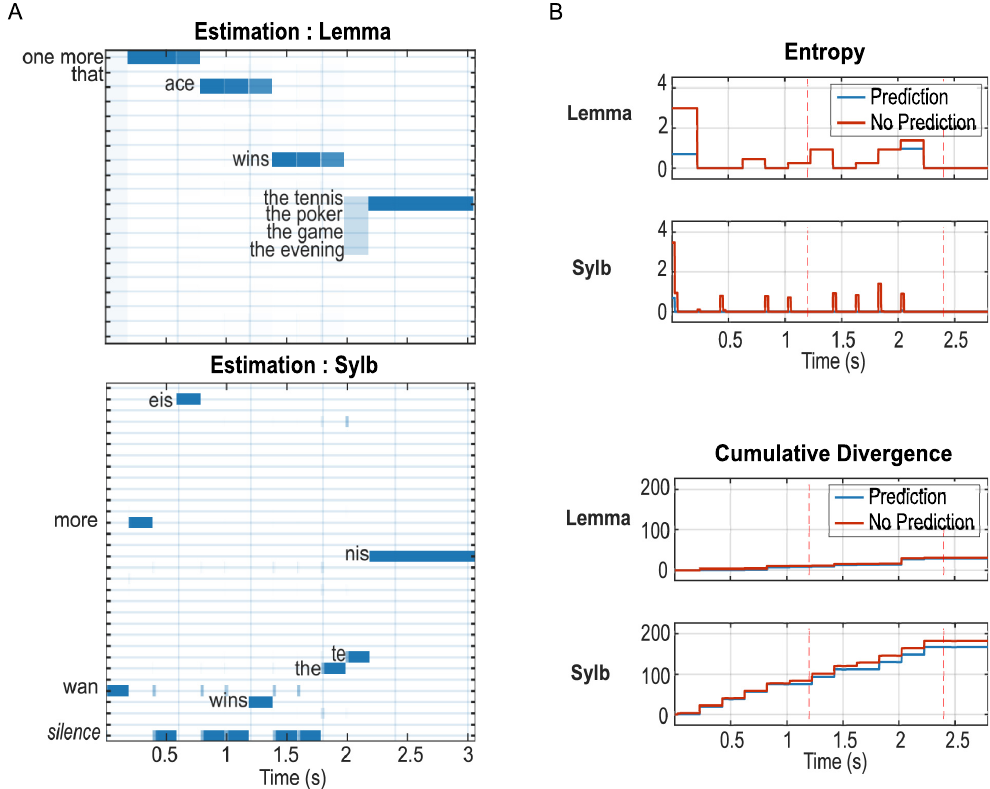
Fig 5. Influence of top-down predictions on syllable and lemma inference under high peripheral precision. All results are simulated with the sentence “One more ace wins the tennis”. With uninformative predictions, model responses at the semantic and context levels are nearly identical to Fig 2A because the model reached the same, almost-certain lemma estimates at the time of semantic updating (at each lemma offset). Therefore we omit the higher-level results here and in Fig 6. ( A) Estimation of posterior probabilities when top-down predictions are set to uniform distributions for all possible states. Compared to Fig 4B, there is a slight delay for the convergence of every syllable indicated by the small vertical bars, each corresponding to one spectral vector, in more than one possible state. The inference for lemma states is not significantly changed: Once the model is certain about the first (or the second in the case of the last lemma) syllable, it can quickly converge to the correct lemma using its internal knowledge. ( B) Upper panels: entropy calculated from lemma and syllable states. With uninformative top-down prediction (red), the entropy of syllable states was raised for a short duration (approximately 1–2 spectral vectors) more often than with informative (blue) prediction (eight times throughout the sentence versus once at the sentence onset). The difference is less obvious at the lemma level except during the very first syllable and the /the/ syllable in the last lemma. Lower panels: cumulative KL divergence for the two factors. Overall, the cumulative divergence is smaller when informative prediction is available (blue). Simulated data supporting the figures can be found in ace_tennis_context1_5_NNP.mat (Fig 5A and 5B) and ace_tennis_context1_5 (Fig